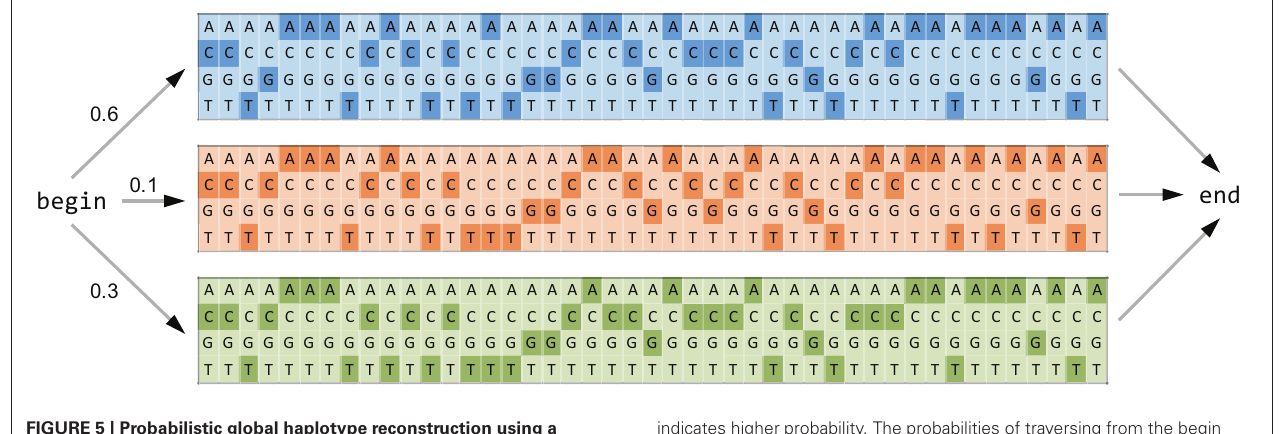
FIGURE 5 | Probabilistic global haplotype reconstruction using a generative mixture model. Each of the three haplotypes colored as in Figure 2 (A, blue; B, orange; and C, green) is represented as a chain of probability tables over the four nucleotides, where darker shading of a base